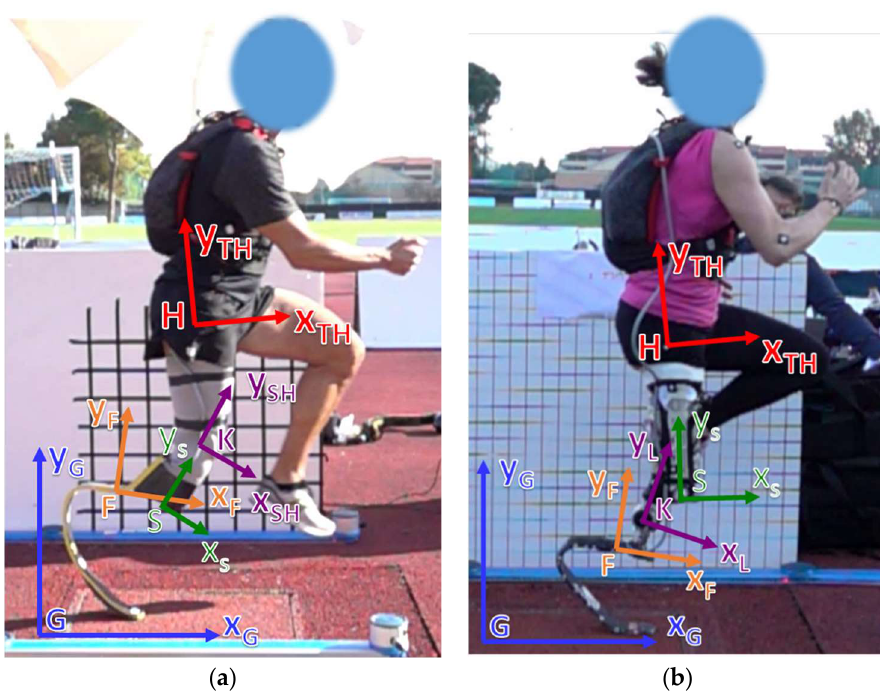
Figure 2. Reference Systems in the sagittal plane associated to athlete’s limbs and to different components of the Running Prosthetic System allow expressing their absolute and relative orientation and resolving loads coming from the ground contact for a ( a ) TT amputee or ( b ) a transfemoral amputees (TF) and knee-disarticulated athletes (KD) amputee. See Appendix A for reference systems definitions.